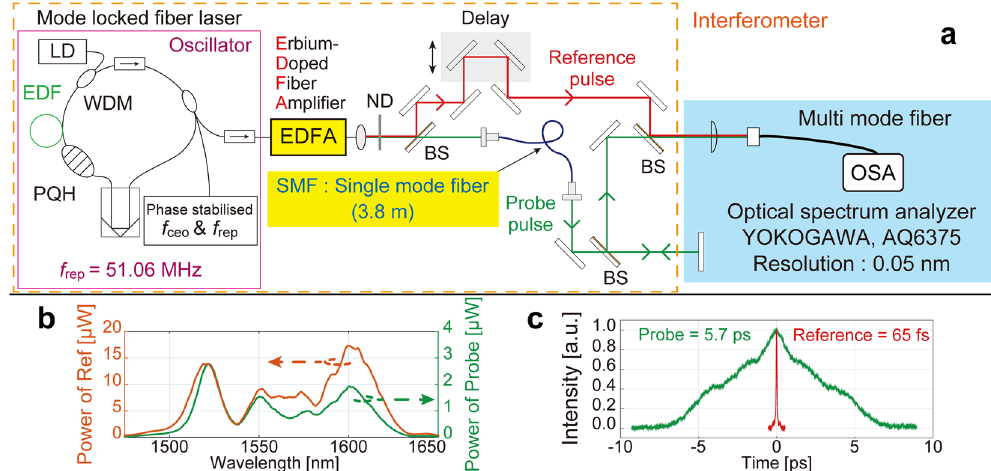
Figure 2. Schematic of the experimental setup. ( a ) Experimental setup for the position measurement. LD: laser diode, WDM: wavelength division multiplexing coupler, PQH: polarization controller, EDF: erbium- doped fibre, ND: neutral density filter, and BS: beam splitter with f rep : 51 MHz, central wavelength: 1.56 µ m, and average power: 8 mW after EDFA. ( b ) The optical spectra and ( c ) autocorrelation traces for the reference and probe